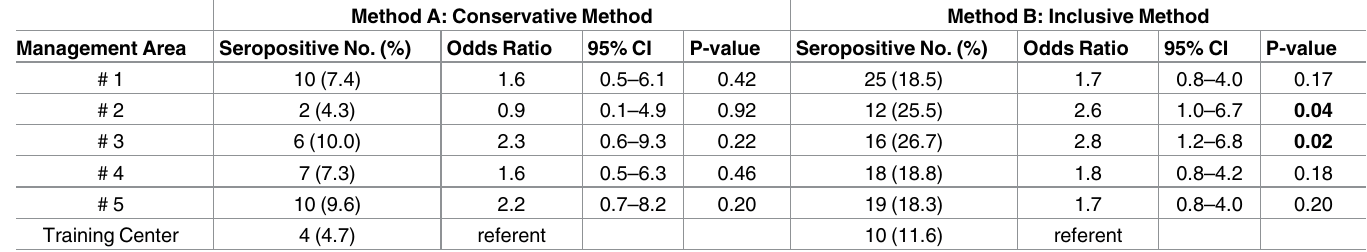
Table 3. Association between management areas or training center and seropositive dogs with seropositivity defined using method A (including very faint serological bands as negative) and method B (including very faint serological bands as positive).